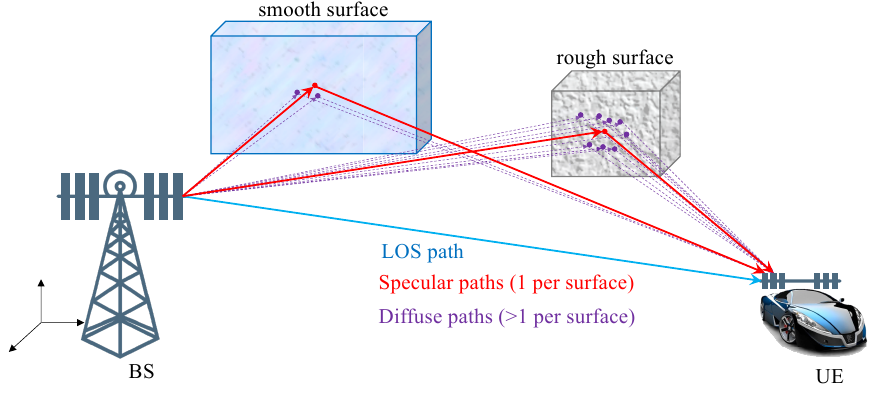
Figure 1. In mmWave simultaneous localization and mapping (SLAM) applications, each object can give rise to a specular path as well as multiple diffuse paths. The number and spread of these diffuse paths depend on the roughness of the object. At the receiver side, diffuse paths from an object have similar delays and angles, so that they can only be resolved with sufficient bandwidth and number of